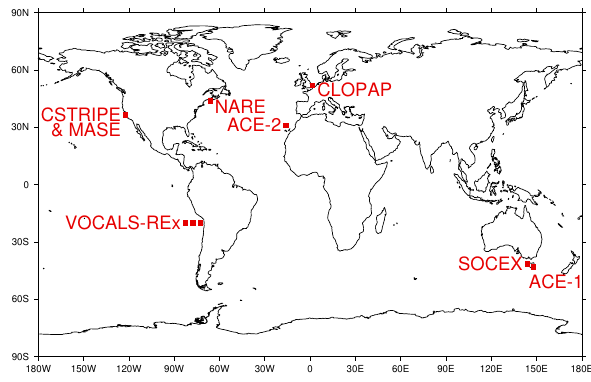
at hybrid height of 720m (AWM=0.51).